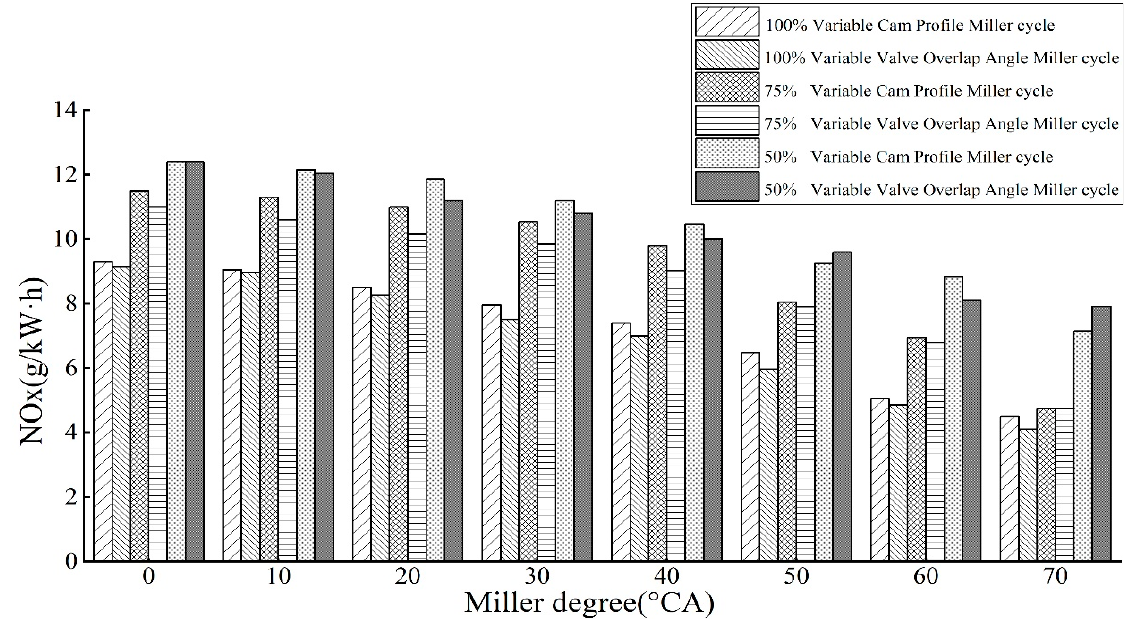
Figure 8. NO X emission analysis under three working